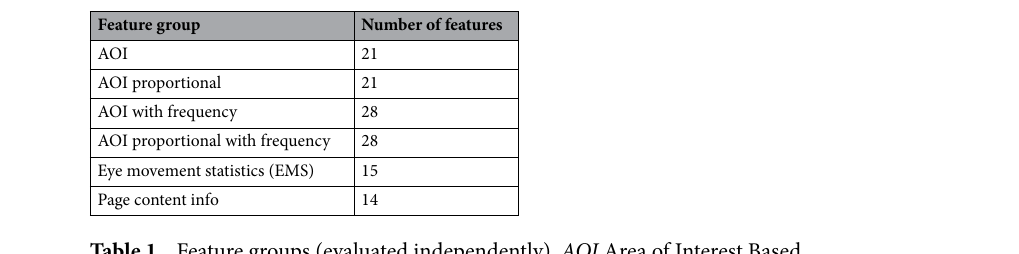
Table 1. Feature groups (evaluated independently). AOI Area of Interest